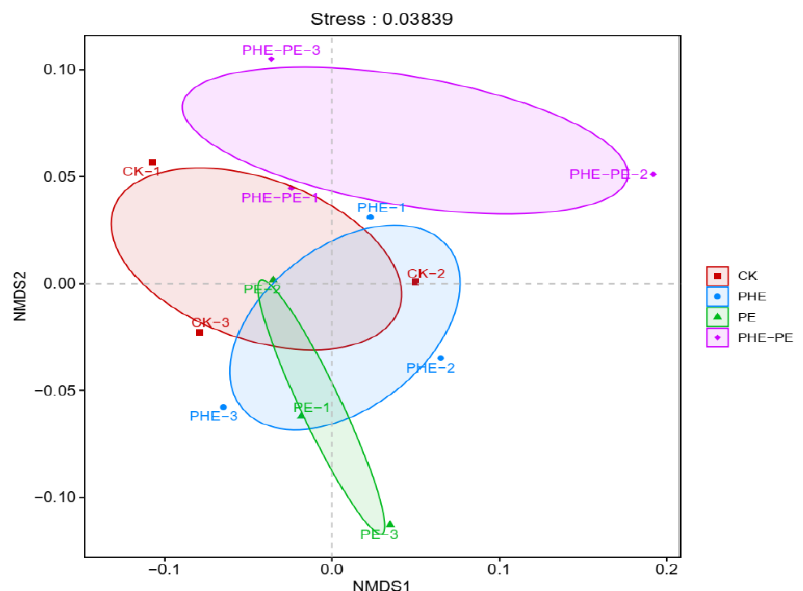
Figure 2. NMDS showing the distribution pattern of CK and different treated groups (PE, PHE and PHE ‐ PE).